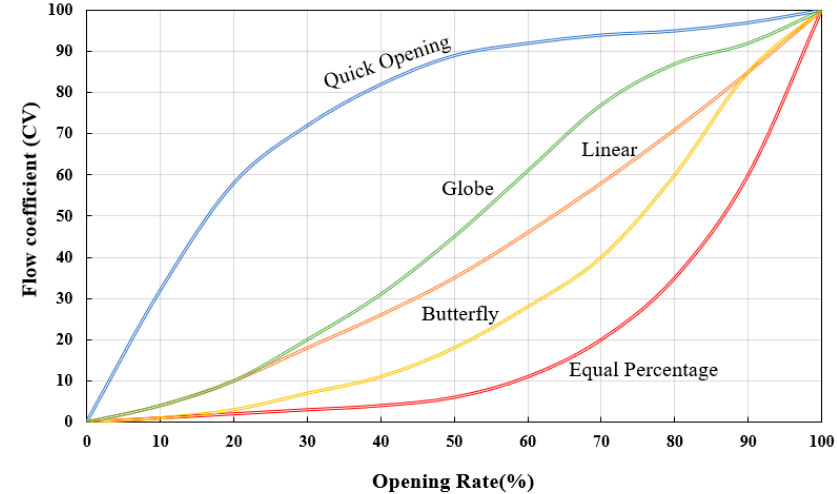
Figure 2. The curves of the inherent flow characteristics for various